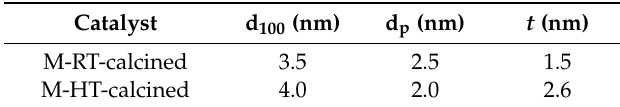
Table 2. Interplanar distances of the (100) planes (d 100 ), pore diameters (d p ), and wall thicknesses ( t ) of the calcined